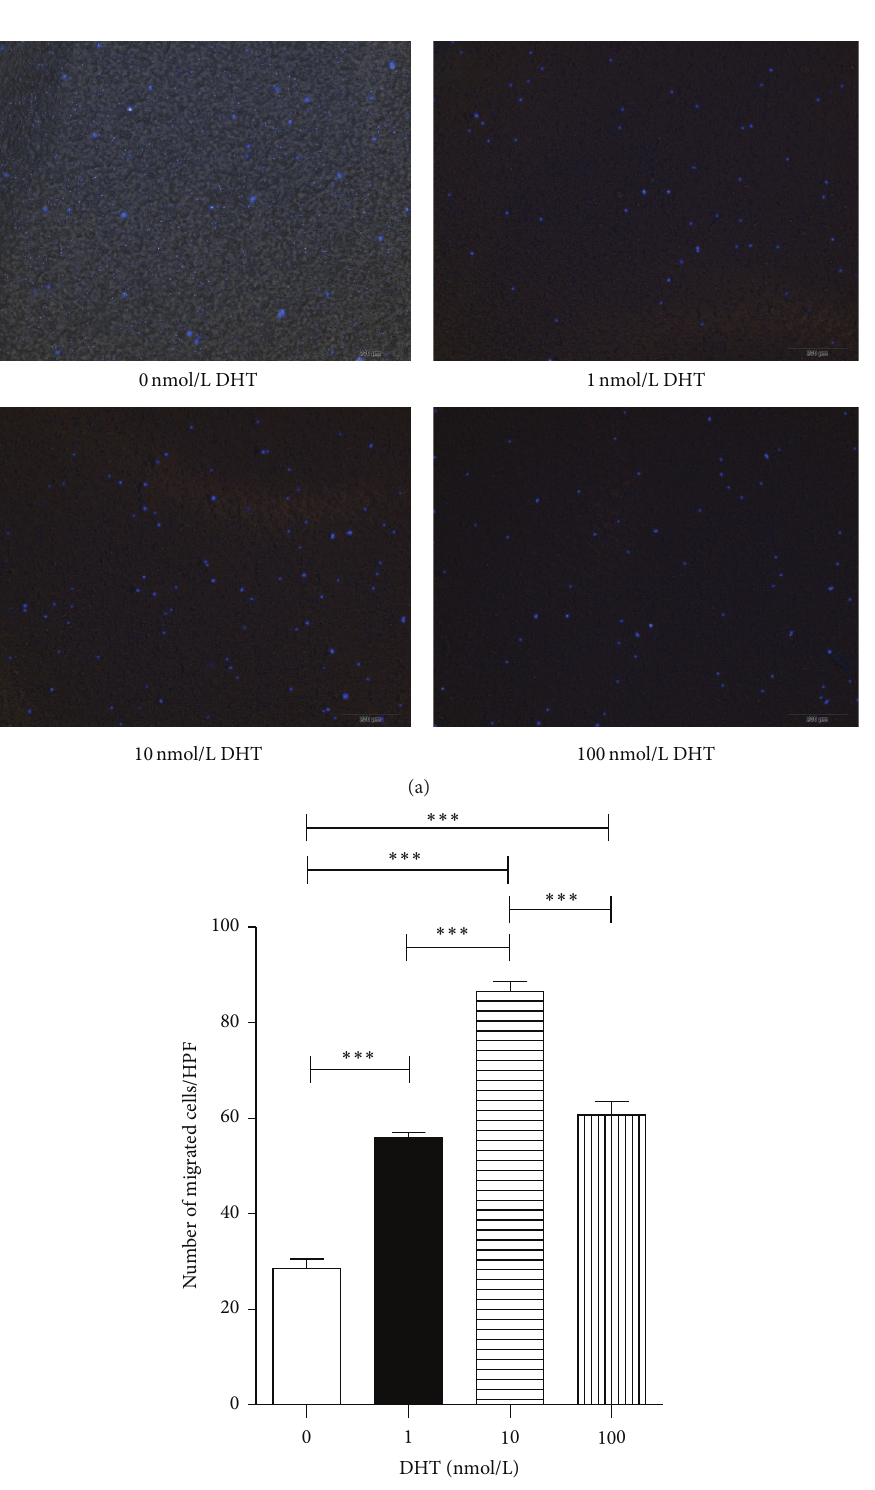
Figure 4: Transwell assay of EPCs. DHT-treated or nontreated EPCs were incubated in the upper chamber with the serum-free medium. And the lower chamber was filled with 15% FBS/DMEM. Six hours later, the number of cells that migrated to the bottom of the membrane was quantified after staining with DAPI. (a) Migrating EPCs from serum-free upper chambers to the lower chambers filled with 15% FBS/DMEM. (b) The migrating EPCs were counted and averaged at high power field. All assays were triplicated and demonstrated similar results. Data are presented in mean ± SD format. ∗∗∗ 𝑃 < 0.001 versus control